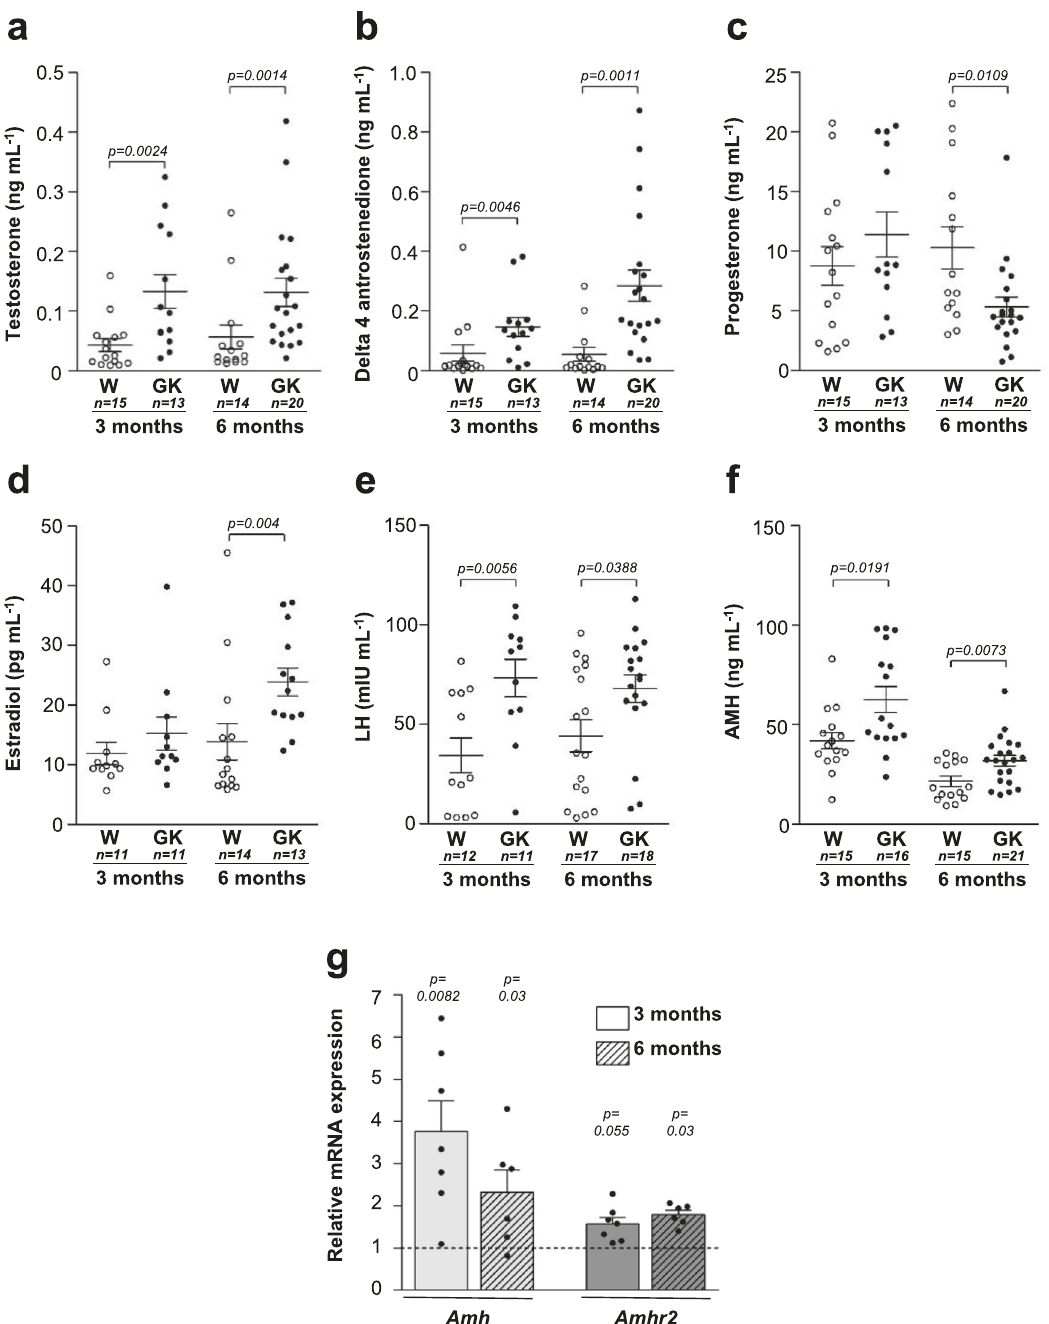
Fig. 4 Hormonal pro fi le of Wistar and GK rats. a – f Serum levels of Testosterone ( a ), Delta-4 androstenedione ( b ), Progesterone ( c ), Estradiol ( d ), Luteinizing hormone (LH) ( e ), and anti-Müllerian Hormone (AMH) ( f ) of 3 and 6 month-old Wistar (W, open symbols) and GK (closed symbols) rats. g Amh (light gray) and Amhr2 (dark gray) mRNA levels in 3 (non-hatched) and 6 (hatched) month-old GK rat ovaries, expressed as box with scatter blot with mean ± SEM (3 months GK rat: n = 7; 6 month-old GK rats: n = 6, fold change relative to Wistar rats; 3 months Wistar rats: n = 6; 6 month-old Wistar rats: n = 5). Unless indicated, data are represented as scatter blot with mean ± SEM. p -values are from two-sided Mann – Whitney U test for unpaired comparisons (GK vs. Wistar rats). n represents the number of biologically independent animals in each group. Source data are provided as a Source Data fi